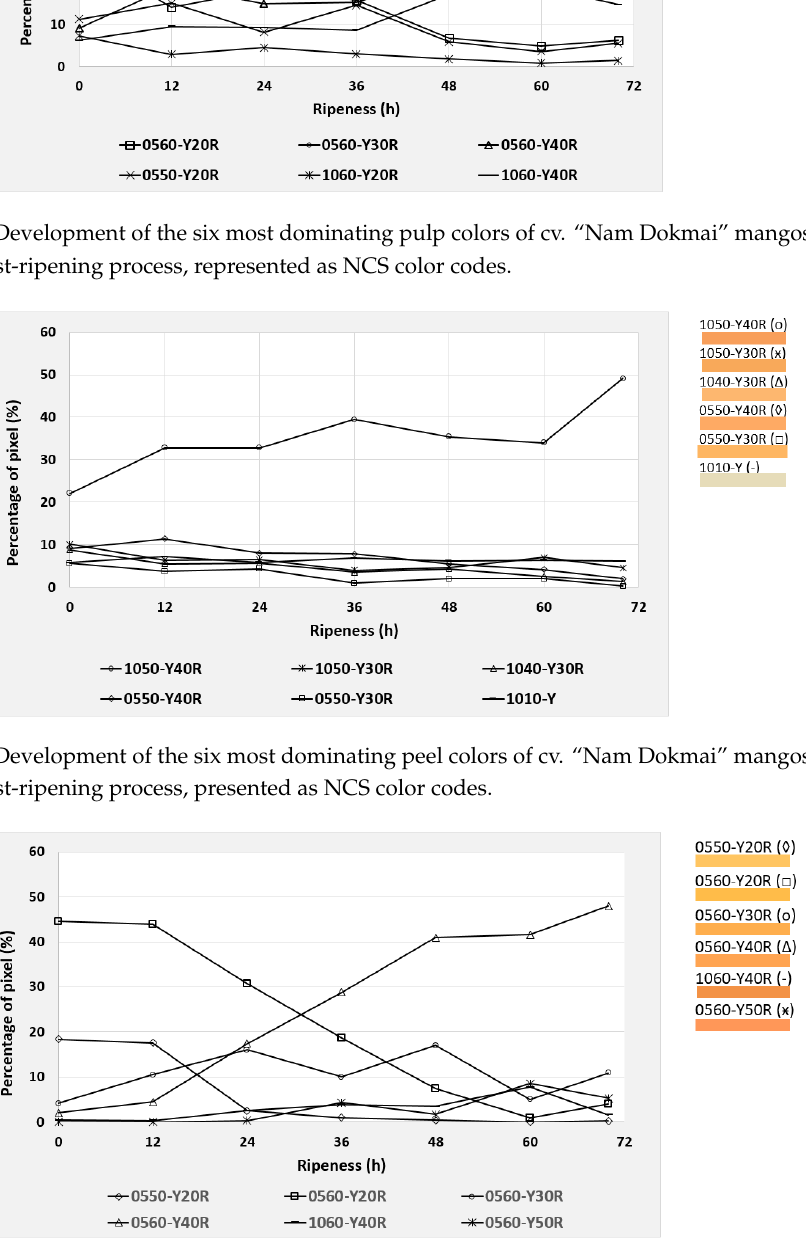
Figure 10. Development of the six most dominating pulp colors of cv. “ Nam Dokmai ” mangos during the 70 h post-ripening process, represented as NCS color codes.